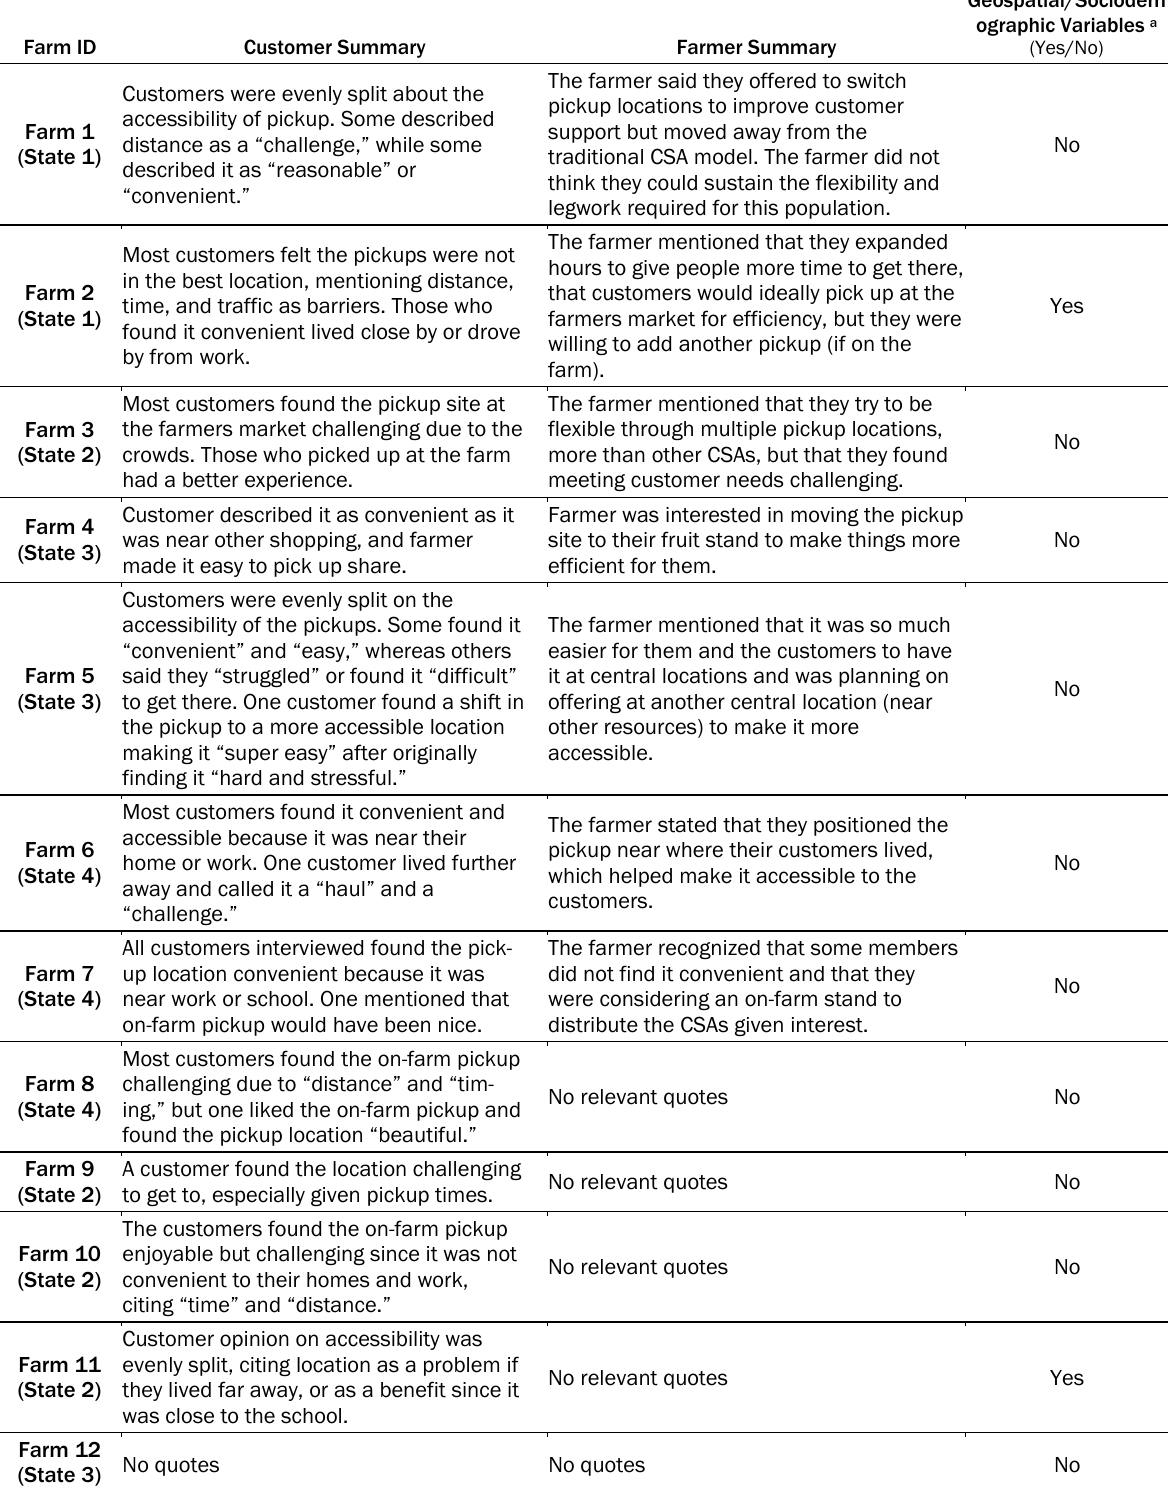
Table 3. Synthesis of Customer Interviews, Farmer Interviews, and Geospatial/Sociodemographic Data